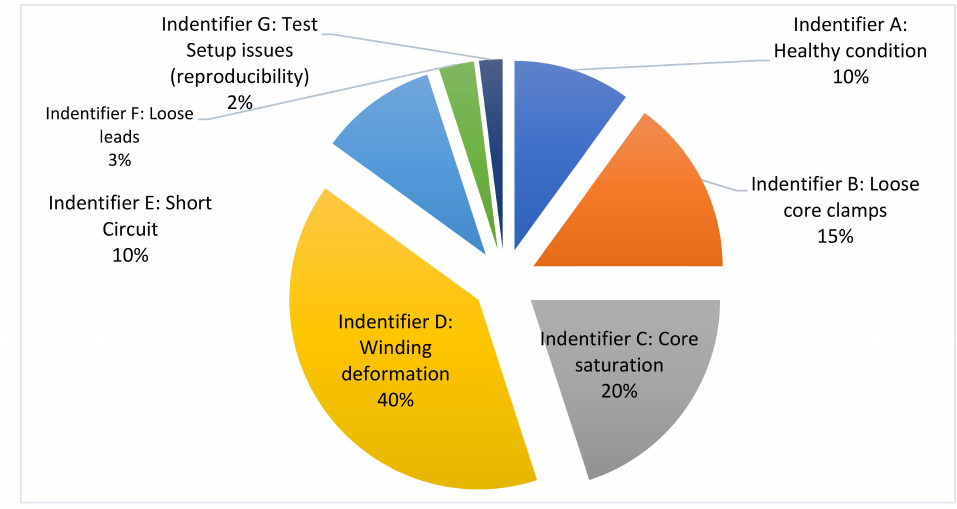
Figure 4. Segmentation of FRA